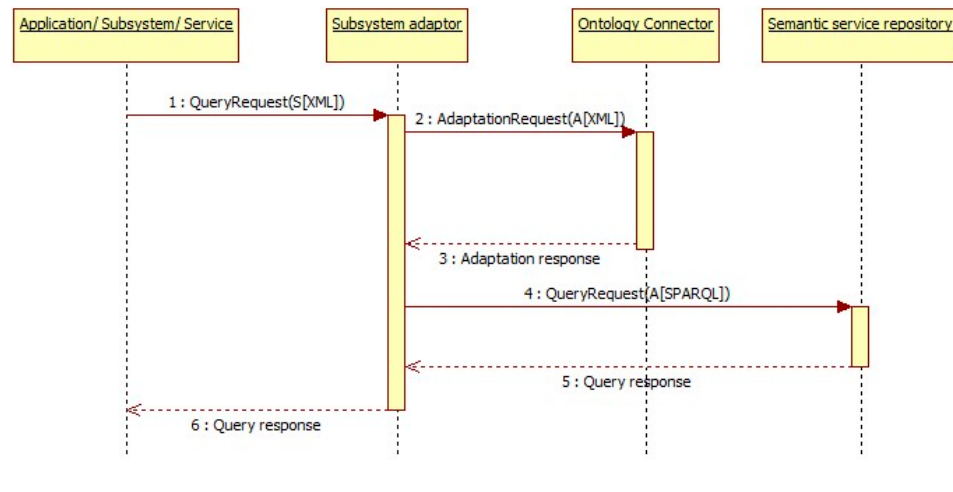
Figure 13. Discovery sequence diagram.